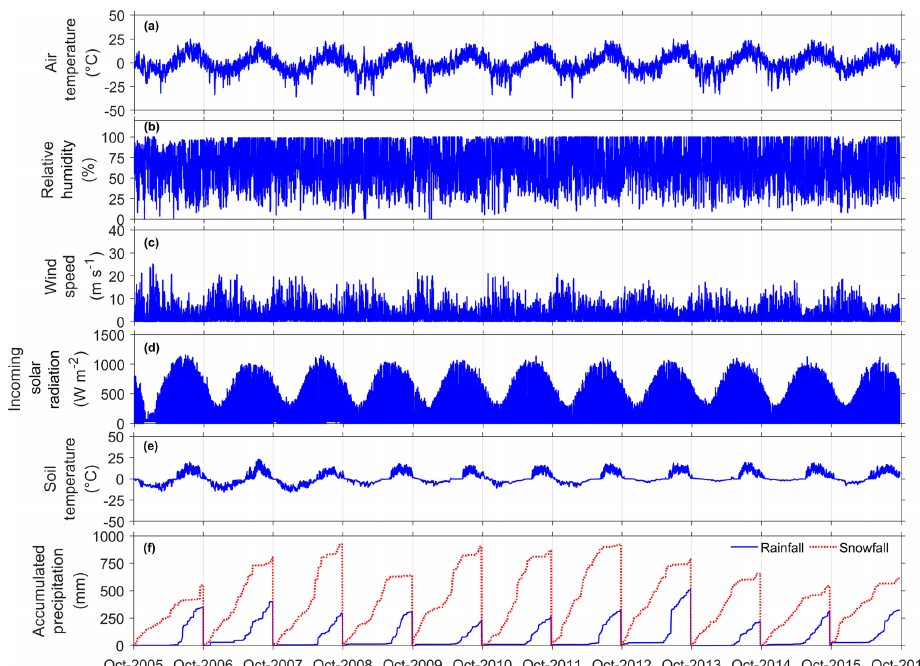
Figure 9. Example of hourly-averaged forcing data from the Fisera Ridge station showing (a) air temperature, (b) relative humidity, (c) wind speed, (d) soil temperature, and (e) rainfall and snowfall for water years starting 1 October. All data are developed from observations except rainfall and snowfall, which are calculated from wind-corrected storage-gauge observations with precipitation phase calculated as per Harder and Pomeroy (2013).